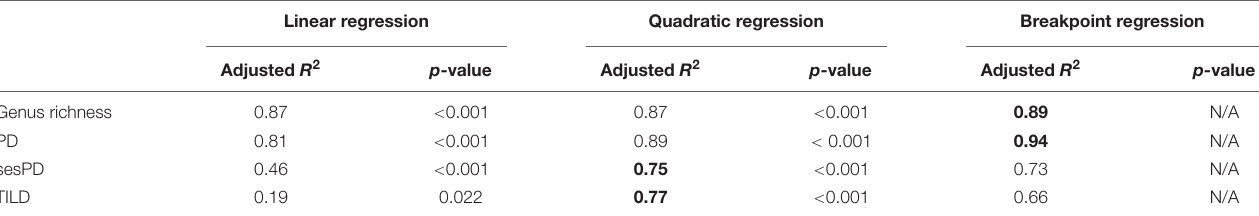
TABLE 1 | Comparison of regression model fits for elevational patterns of genus richness, phylogenetic diversity (PD), standardized effect size phylogenetic diversity (sesPD), and time-integrated lineage diversity (TILD). Linear regression Quadratic regression